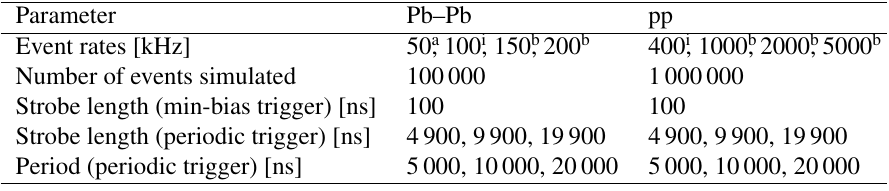
Table 1: Simulation setup for Pb–Pb and pp